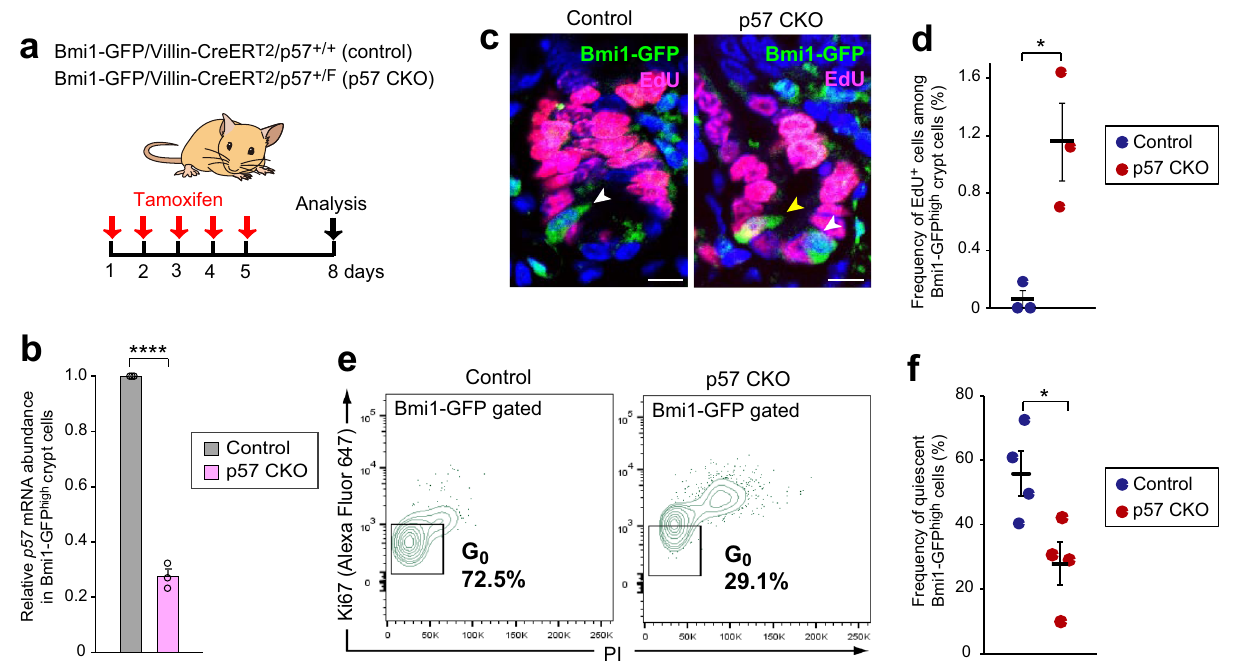
Fig. 2 p57 is required for the maintenance of quiescence in Bmi1 high crypt cells. a Experimental setup for deletion of the maternal allele of the p57 gene in the small intestine. Bmi1-GFP/Villin-CreER T2 /p57 + / + (control) and Bmi1-GFP/Villin-CreER T2 /p57 + /F (p57 CKO) mice were injected intraperitoneally with tamoxifen (50 mg/kg) on 5 consecutive days and were analyzed 3 days after the fi nal injection. b RT-qPCR analysis of relative p57 mRNA abundance in Bmi1 high crypt cells isolated as in Fig. 1h from the small intestine of control or p57 CKO mice ( n = 3 mice). c Representative immuno fl uorescence staining of EdU and Bmi1-GFP in the intestine of control and p57 CKO mice 6 h after intraperitoneal injection of EdU (20 mg/kg). Yellow and white arrowheads indicate Bmi1-GFP high cells positive or negative for EdU, respectively. Scale bar, 10 μ m. d Quantitation of the frequency of EdU + cells among Bmi1-GFP high crypt cells as in c ( n = 3 mice). e Representative fl ow cytometric analysis of the frequency of quiescent (Ki67 – PI – ) cells in the Bmi1-GFP high fraction of intestinal epithelial cells from control and p57 CKO mice treated as in a . f Quantitative analysis for determinations as in e ( n = 4 mice). Quantitative data in b are means + SEM, and those in d and f are means ± SEM. * P < 0.05, ** P < 0.01, **** P < 0.001 (two-tailed Student ’ s t test). Source data are provided as a Source Data fi